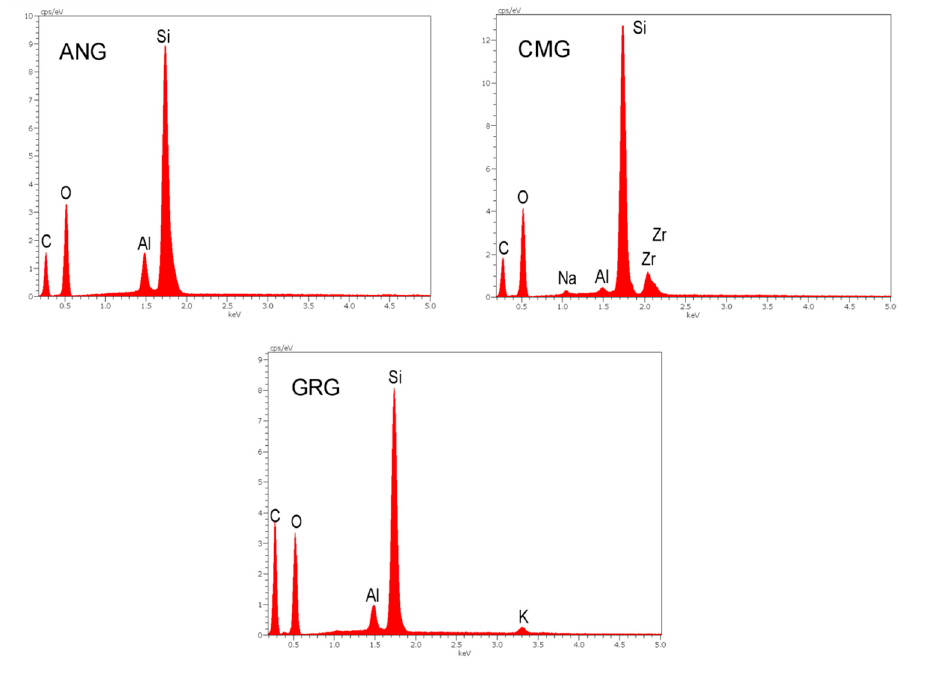
Figure 3. X-ray EDS spectra of the materials. Table 2. The results of the elemental analysis of the materials tested (wt%, means of 3 measurements).